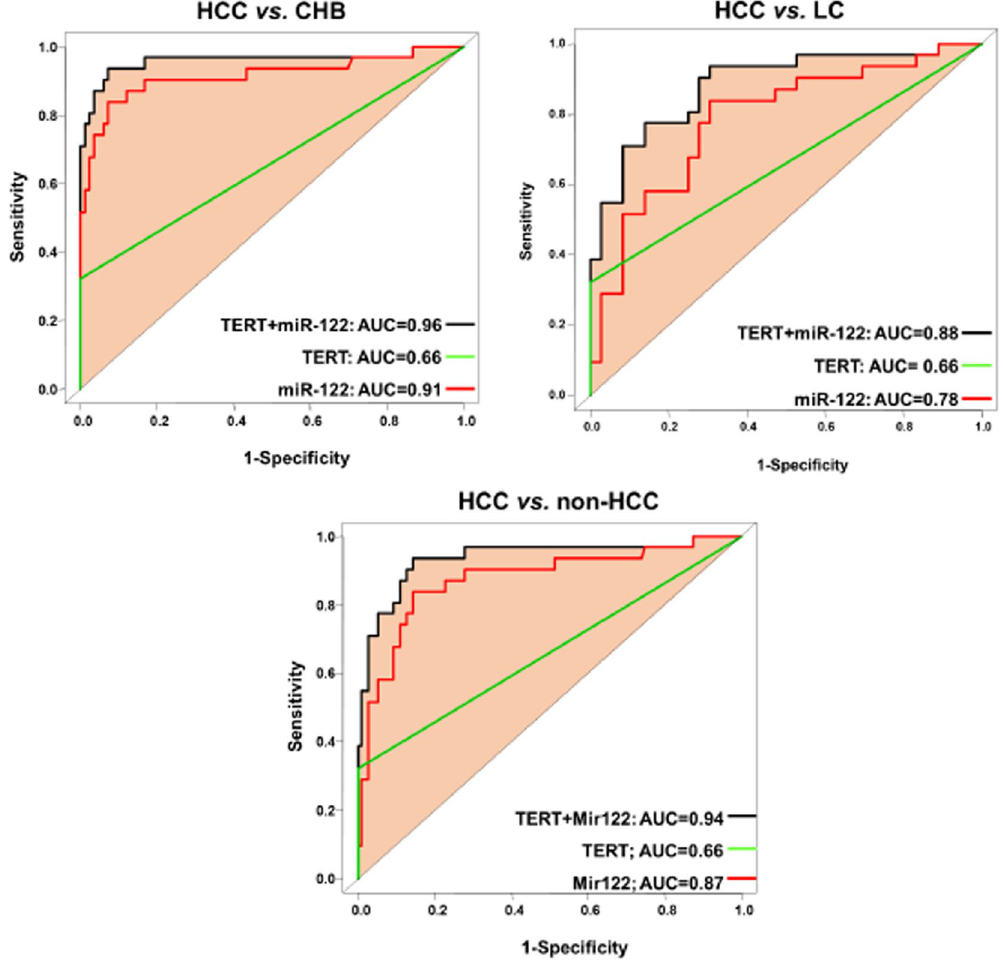
Figure 4. Diagnostic performance of the models with single or double combination of TERT promoter mutation and miR-122 expression in differentiating HCC from other groups at low AFP levels: HCC vs. non- HCC; HCC vs. LC; HCC vs.